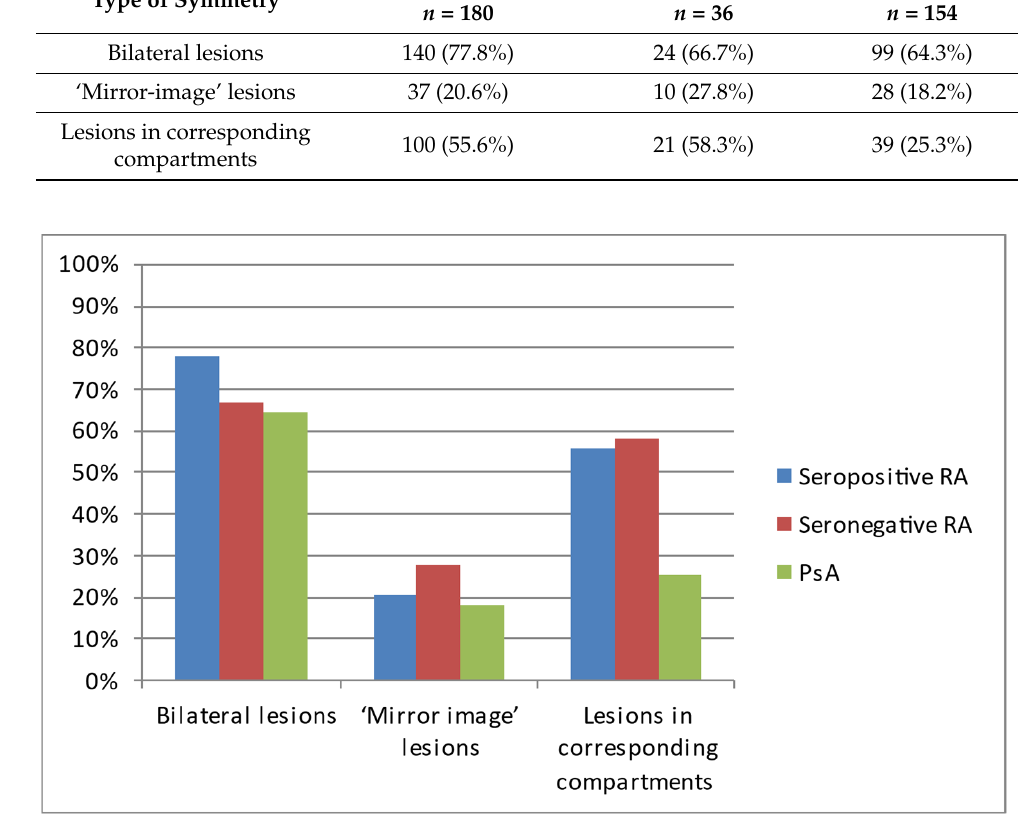
Figure 4. The occurrence of symmetric lesions on hand radiographs of analyzed patients with sero- positive RA, seronegative RA, and PsA. Table 3. Locations of lesions on hand radiographs of analyzed patients with seropositive RA, sero- negative RA, and PsA.